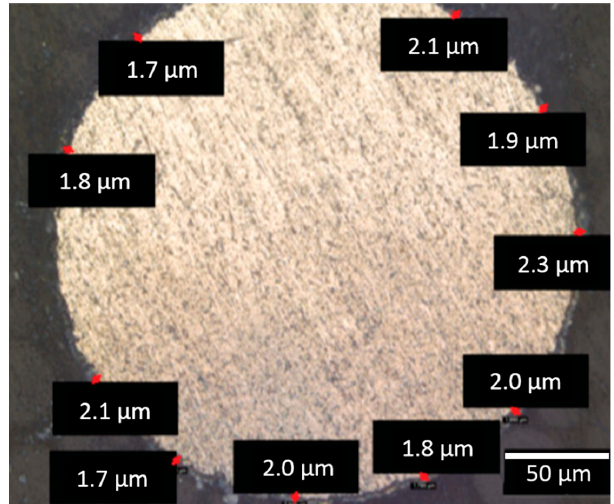
Figure 4. Scanning electron microscopy of BDD-covered niobium wire in cross section. As indicated by the individual measurements (red marks), a uniform coating thickness of approximately 2 µm was achieved (scale bar = 50 µm).